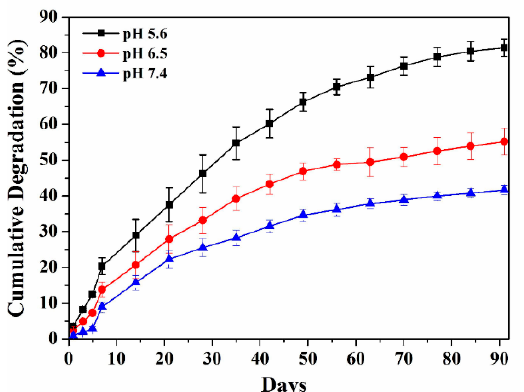
Figure 3. In vitro degradation profiles of HAp-PEI in PBS with various pH values of 5.6, 6.5 and 7.4 at 37 °C.